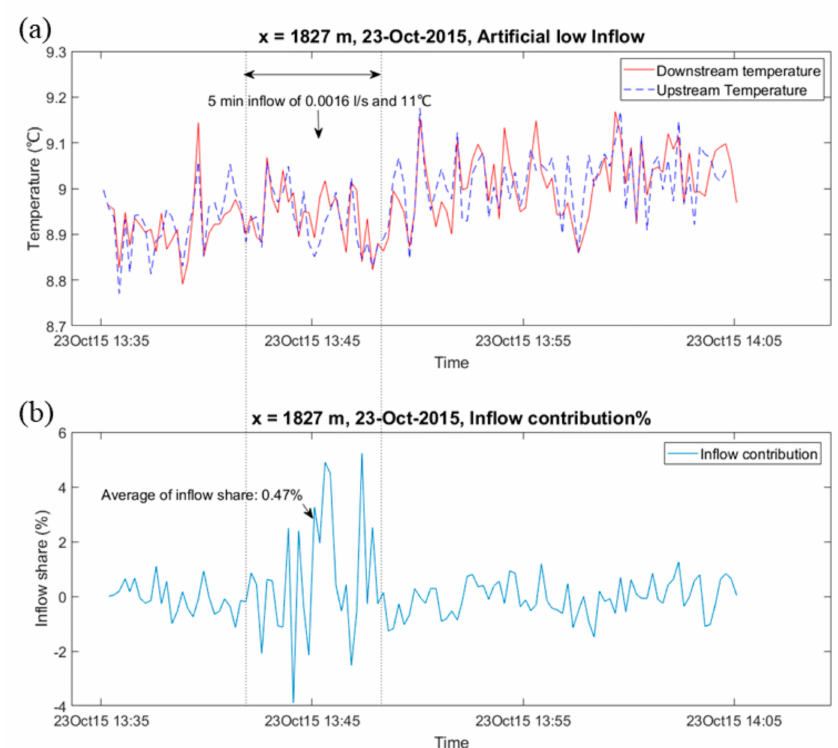
Figure 9. ( a ) Upstream and downstream temperatures on 23 October 2015 around artificial low discharge in x = 1827 m; ( b ) percentage of inflow share in comparison with the upstream